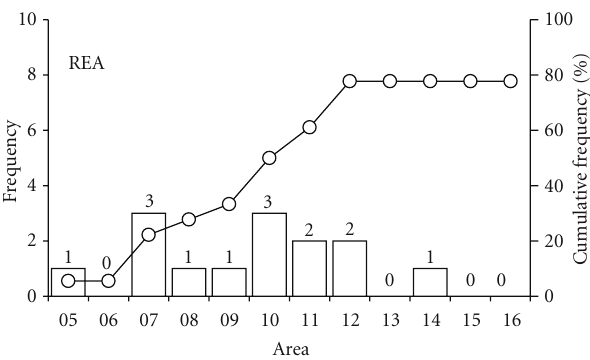
Figure 10: Graphs of full width at a half maximum (FWHM) values from the 5th selected area in 18 samples and its respective representative elementary areas (REA) for a 10% deviation, when REA was